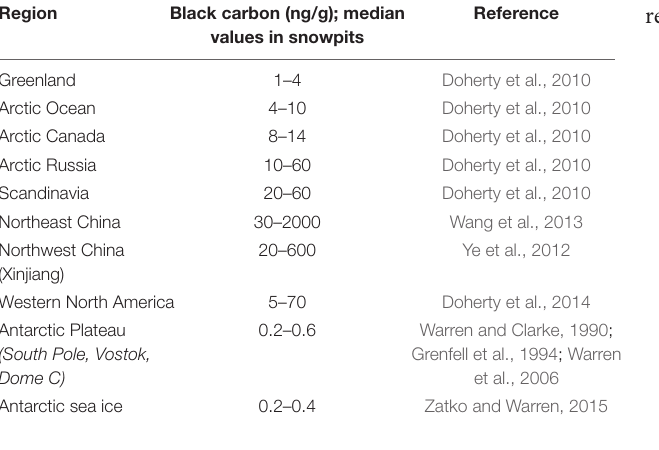
TABLE 1 | Global summary of black-carbon mixing-ratios in snow before the onset of melt (winter in midlatitudes; spring in the Arctic and Antarctic). Region Black carbon (ng/g); median values in